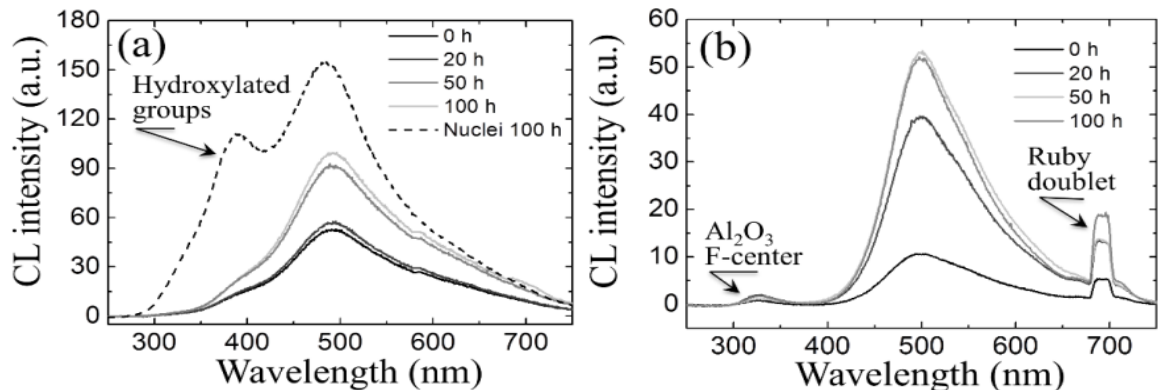
Figure 10. In ( a ) and ( b ), average CL spectra for 3Y-TZP Samples A and B, respectively, which were collected during increasingly long exposures in autoclave up to 100 h.